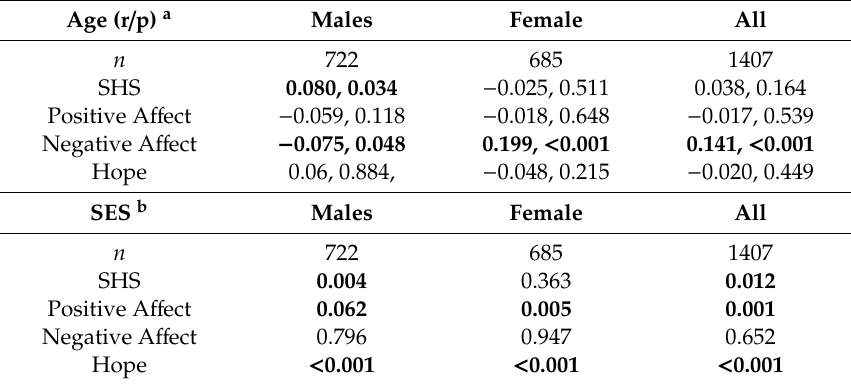
Table 2. Correlations between age / SES and wellbeing indicators, in participants as a whole and by